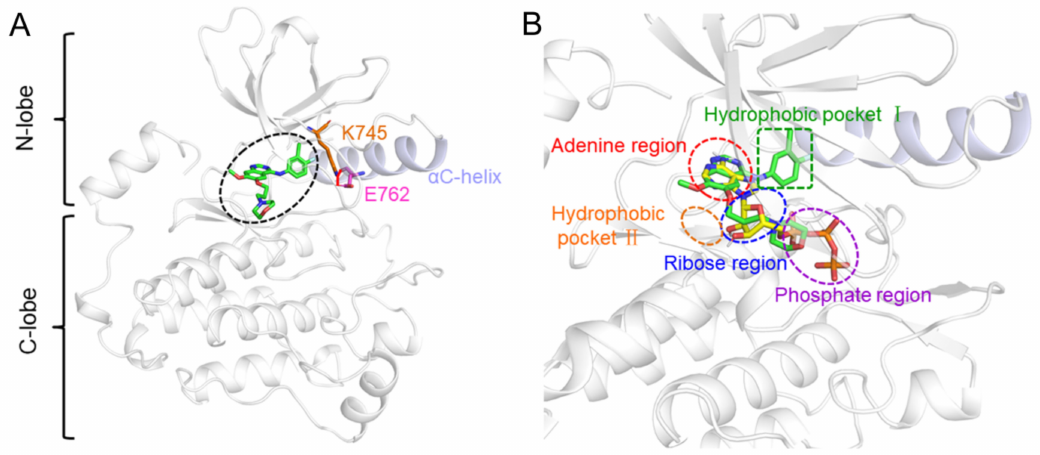
Figure 1. The structure of EGFR is complex with IRE in the absence ( A ) and presence ( B ) of ATP. The α C-helix is marked in light blue. The residues E762 and K745 forming a salt bridge are shown as orange and magenta sticks, respectively. The small molecules IRE and ATP are shown as green and yellow sticks, respectively. The IRE binding site is highlighted by a black circle in ( A ), and the five regions consisting of the catalytic cleft are highlighted by circles with different colors in ( B